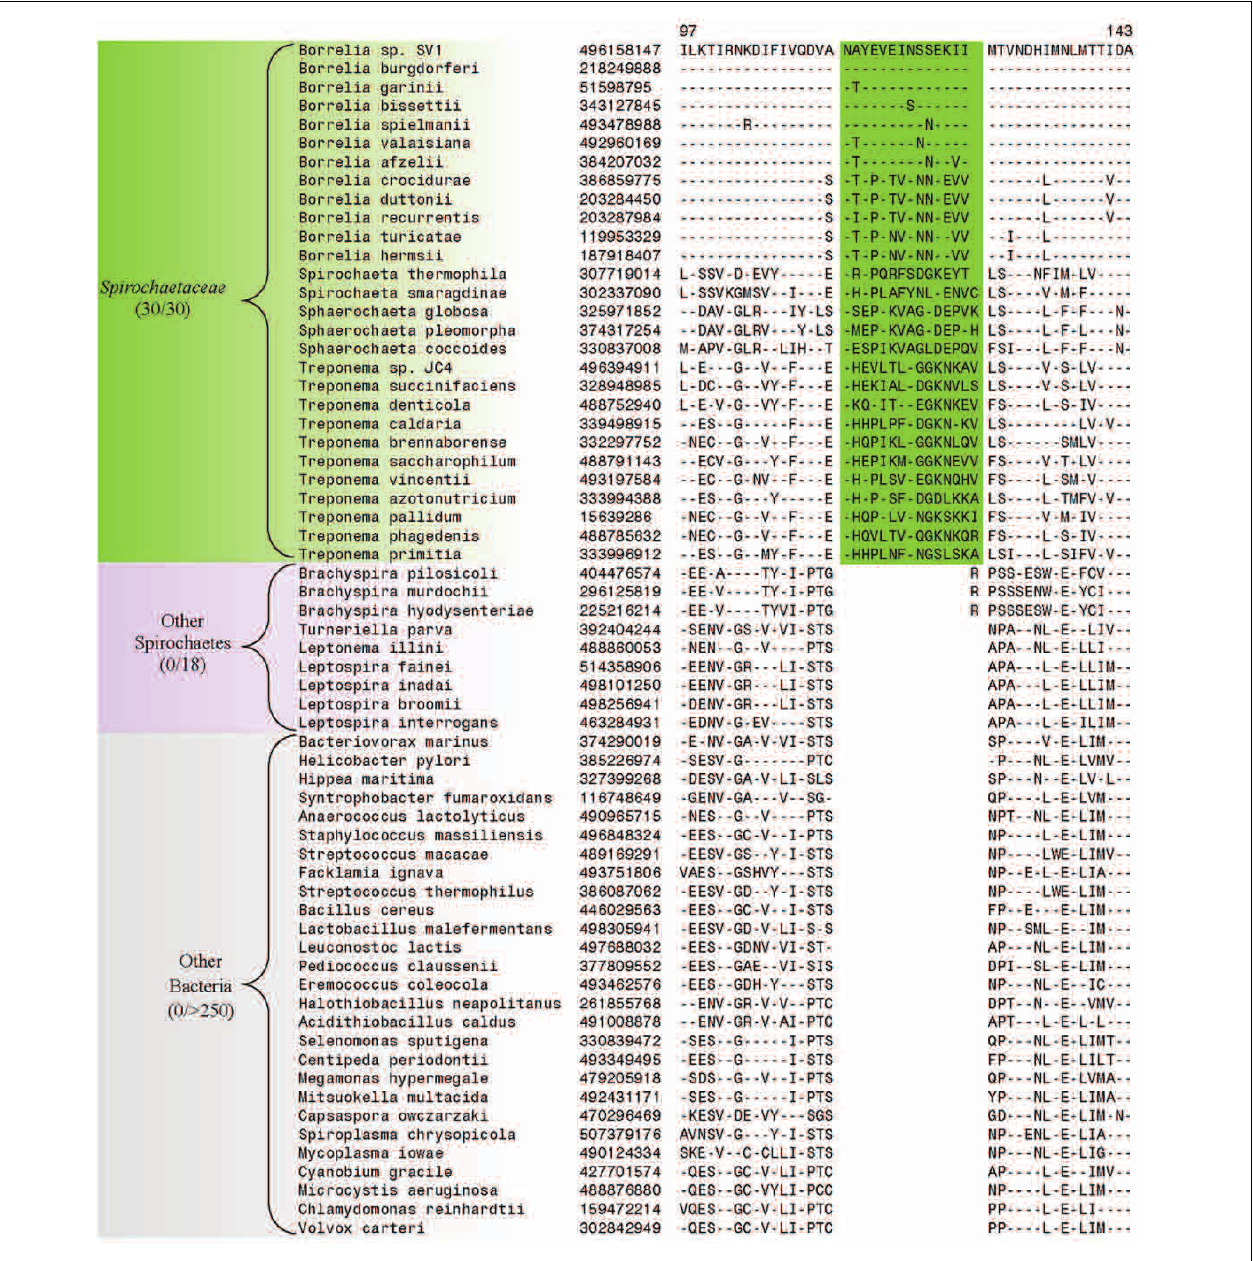
FIGURE 4 | A partial sequence alignment of the protein alanyl-tRNA synthetase showing a two amino acid insertion (boxed) identified in homologs from the family Spirochaetaceae , but not found in the